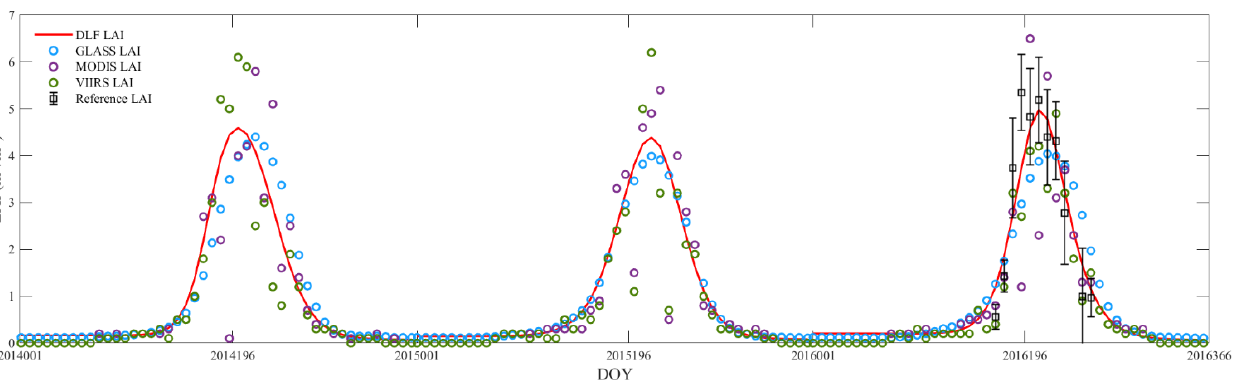
Figure 3. DLF, GLASS, MODIS, VIIRS, and reference LAIs during 2014 – 2016.